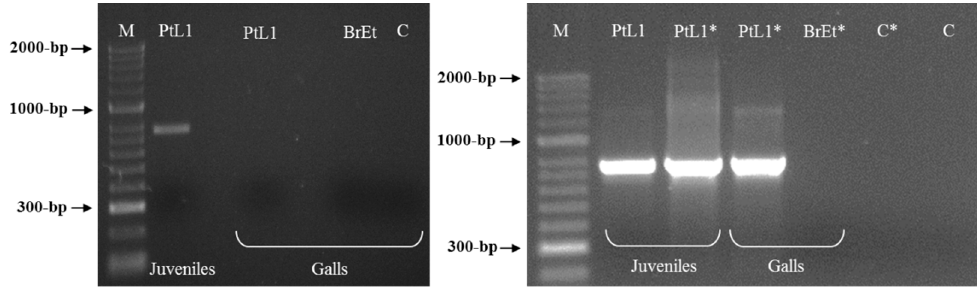
Figure 5. PCR product for Meloidogyne luci (isolate PtL1) infected tomato root (individual gall) using the species-specific primer pair Mlf/r. Tomato infected root with M. ethiopica (isolate BrEt) was included for comparison. For isolate codes see Table 1. * Re-amplification; M—DNA marker (HyperLadder II, Bioline); C—Negative control.